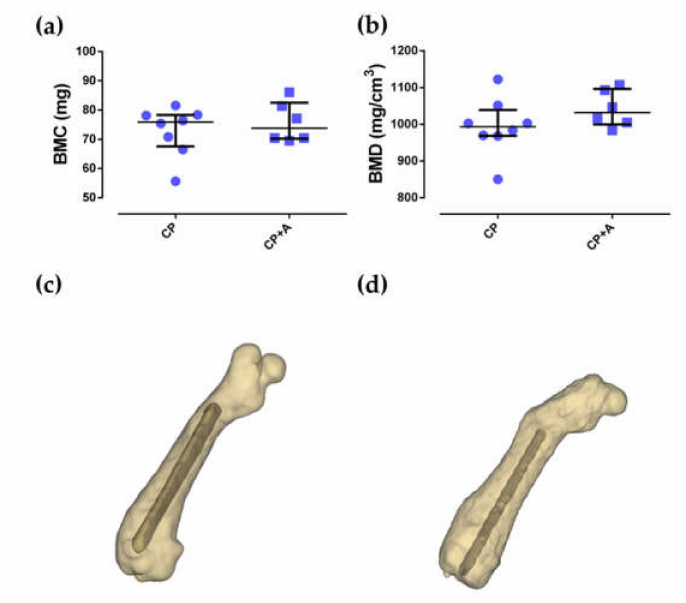
Figure 7. Bone mineral content (BMC) ( a ) and bone mineral density (BMD) (b ) and their three- dimensional reconstructions of a representative sample of the CP group ( c ) and CP + A group ( d ). Hematoxilin-eosin staining showed no differences in tissue in the area occupied by the implant among the mice with CP- and CP + A-implants. When bone markers were analysed in the defect area, no changes were observed among the different animals, in alkaline phosphatase (ALP) staining, Cathepsin K or cluster of differentiation 68 (CD68) (Figure 8).